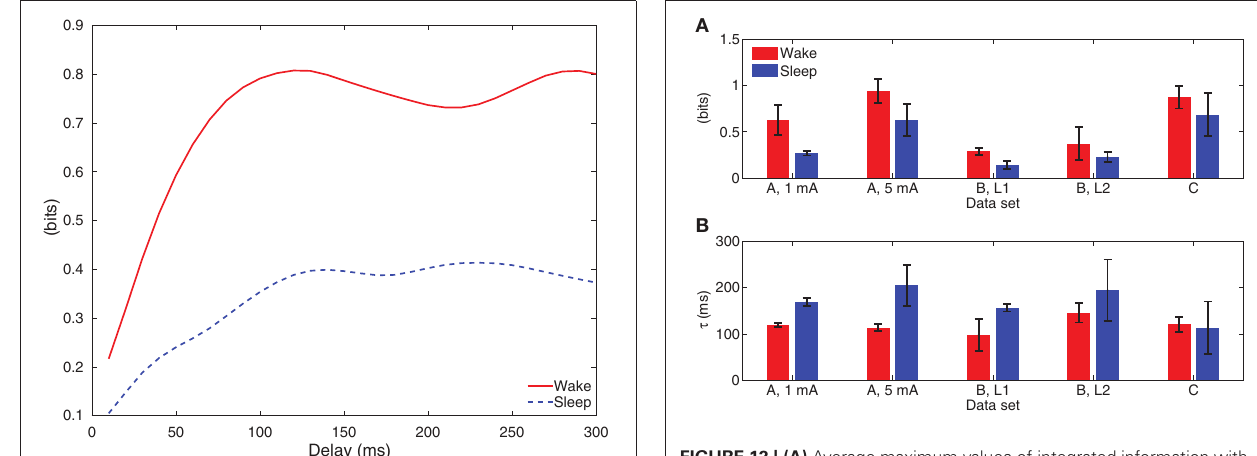
have p -values below 0.05, and Subject C is only slightly above 0.05.